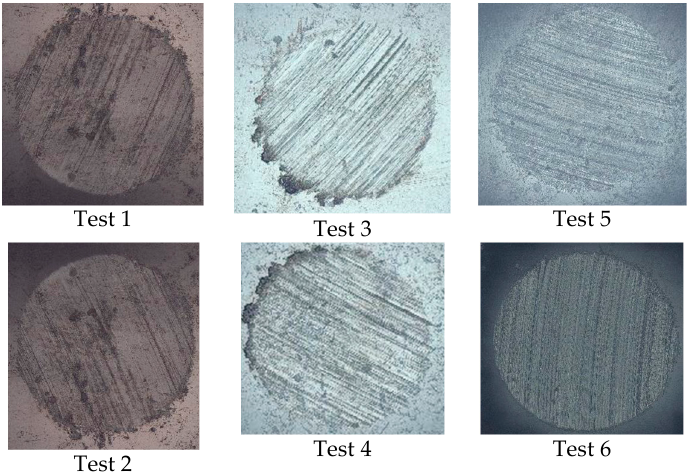
Figure 11. wear scars on balls after testing. Figure 11. Wear scars on balls after